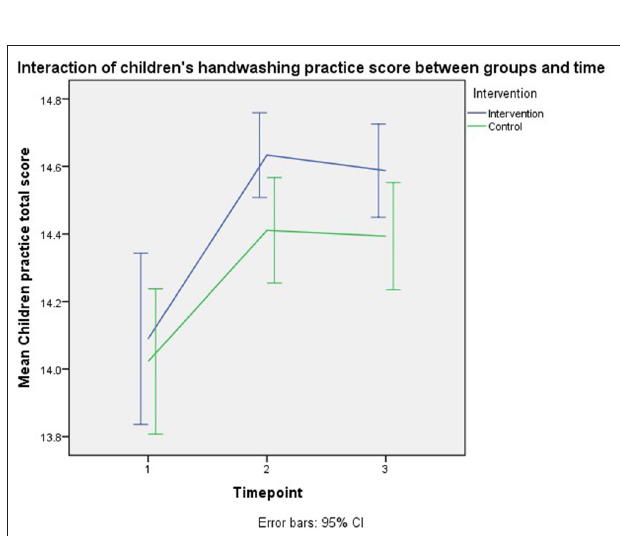
FIGURE 7 | Interaction of children’s handwashing practice score between groups and time.